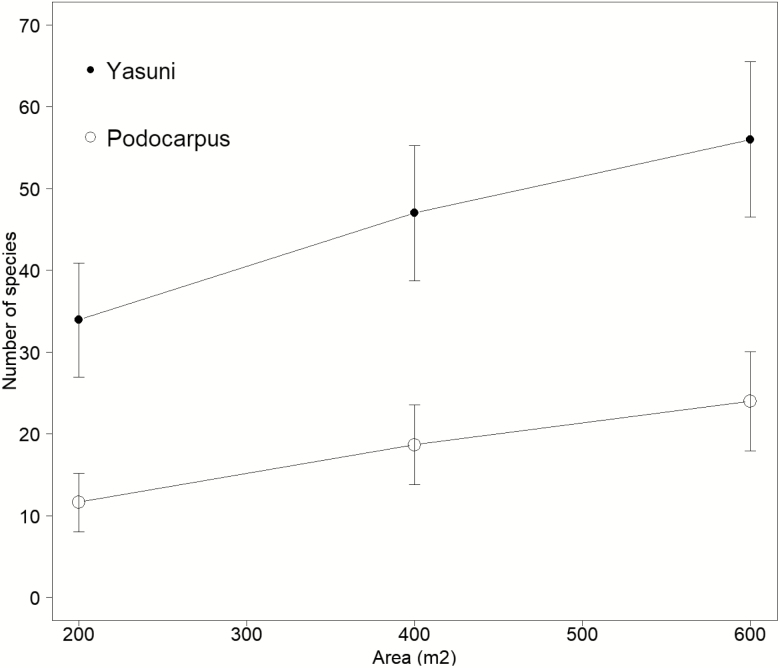
Termite species rarefaction curves (Mao-Tau) with 95% confidence intervals for each transect in Yasuní and Podocarpus. Three transects were sampled in each study site and the x-axis shows the accumulated sampling area (each transect covers 200 m2).